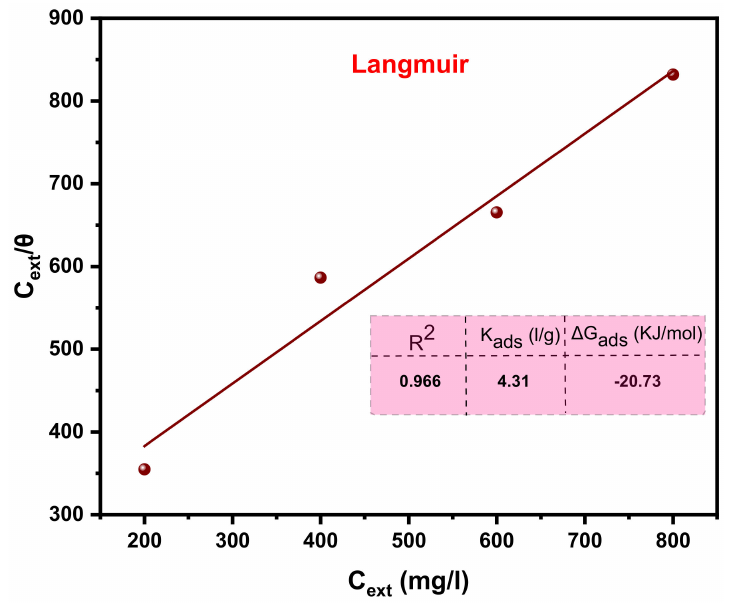
Figure 6. Langmuir adsorption isotherm of the extract CHA of the plant Artemisia herba-alba .